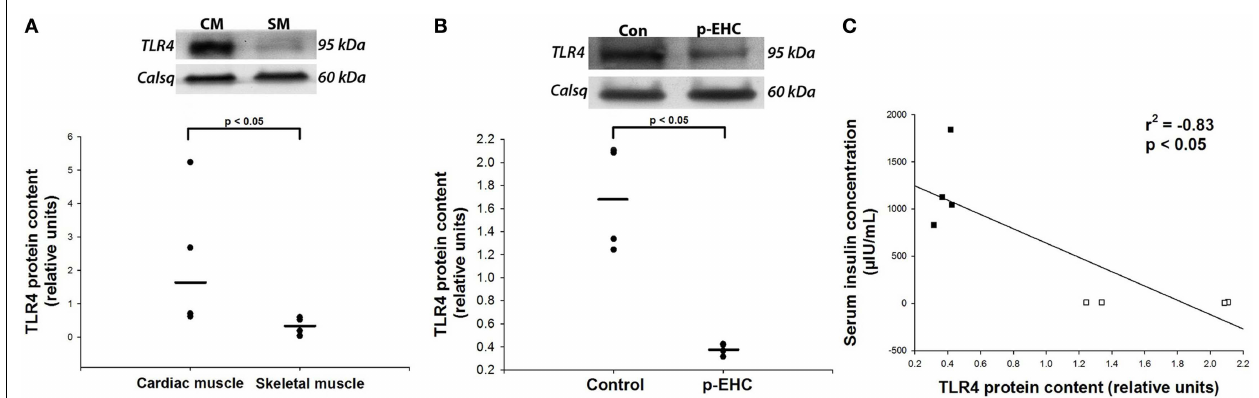
FIGURE 2 | Prolonged hyperinsulinemia down-regulates cardiacTLR4 expression . (A,B) RepresentativeWestern blot ofTLR4 protein expression from crude membrane fractions; calsequestrin (Calsq) was used as a loading control. (A) TLR4 protein expression is greater ( p < 0.05) in the heart than in skeletal muscle in healthy horses ( n = 4). (B) TLR4 protein expression is